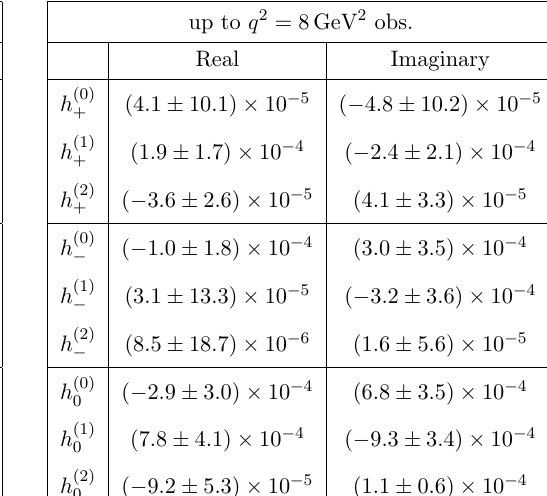
to be constrained. +